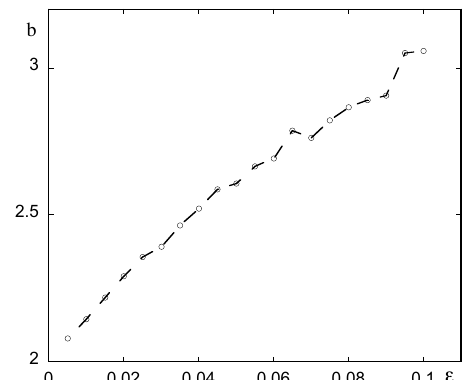
Figure 3. Instantaneous value of parameter b corresponding to the first passage of variable η from threshold | η | = 1 versus the intensity (cid:15) of the ramp parameter with b 0 = 0. Other parameter values as in Fig.